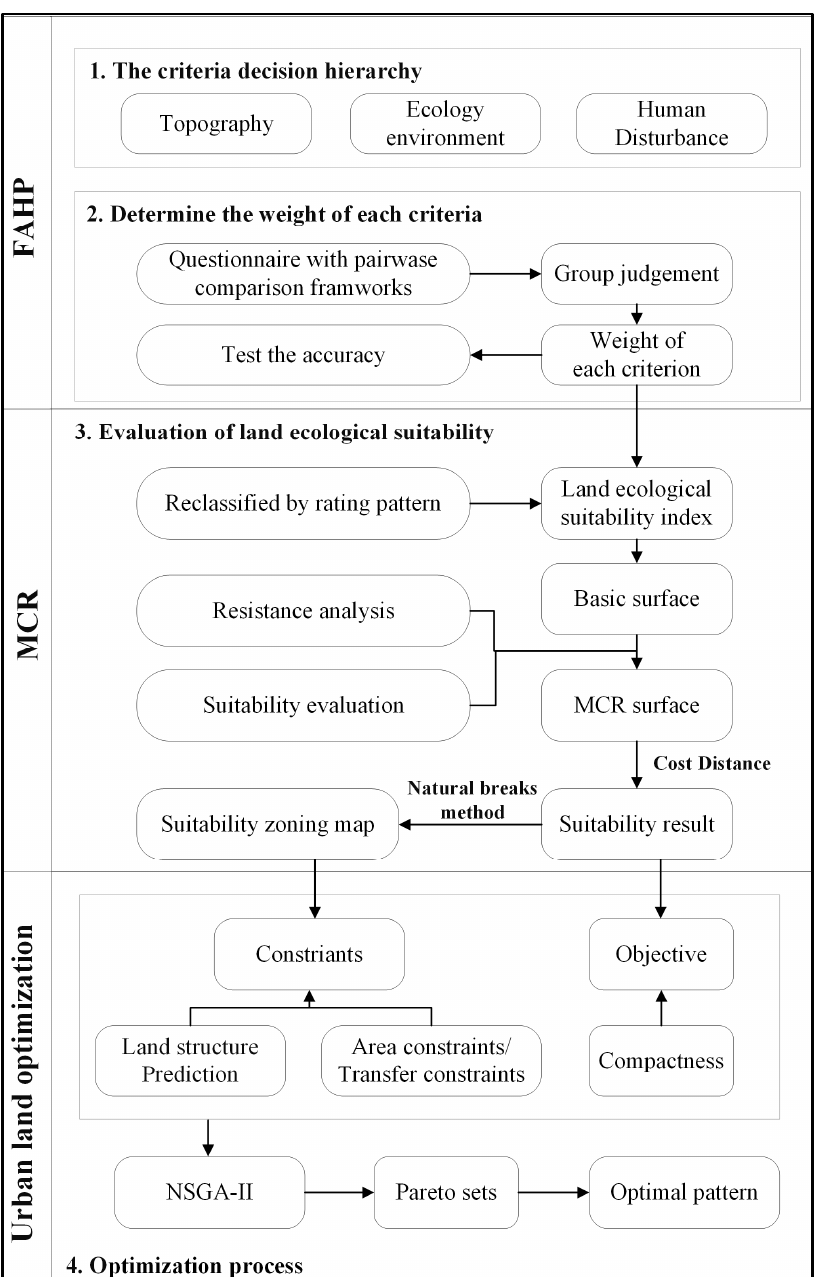
Figure 1. Work fl ow procedure of the multi-objective urban land optimization (MULO) model, Figure 1. Workflow procedure of the multi-objective urban land optimization (MULO) model, which which includes FAHP, MCR model and NSGA-II. includes FAHP, MCR model and